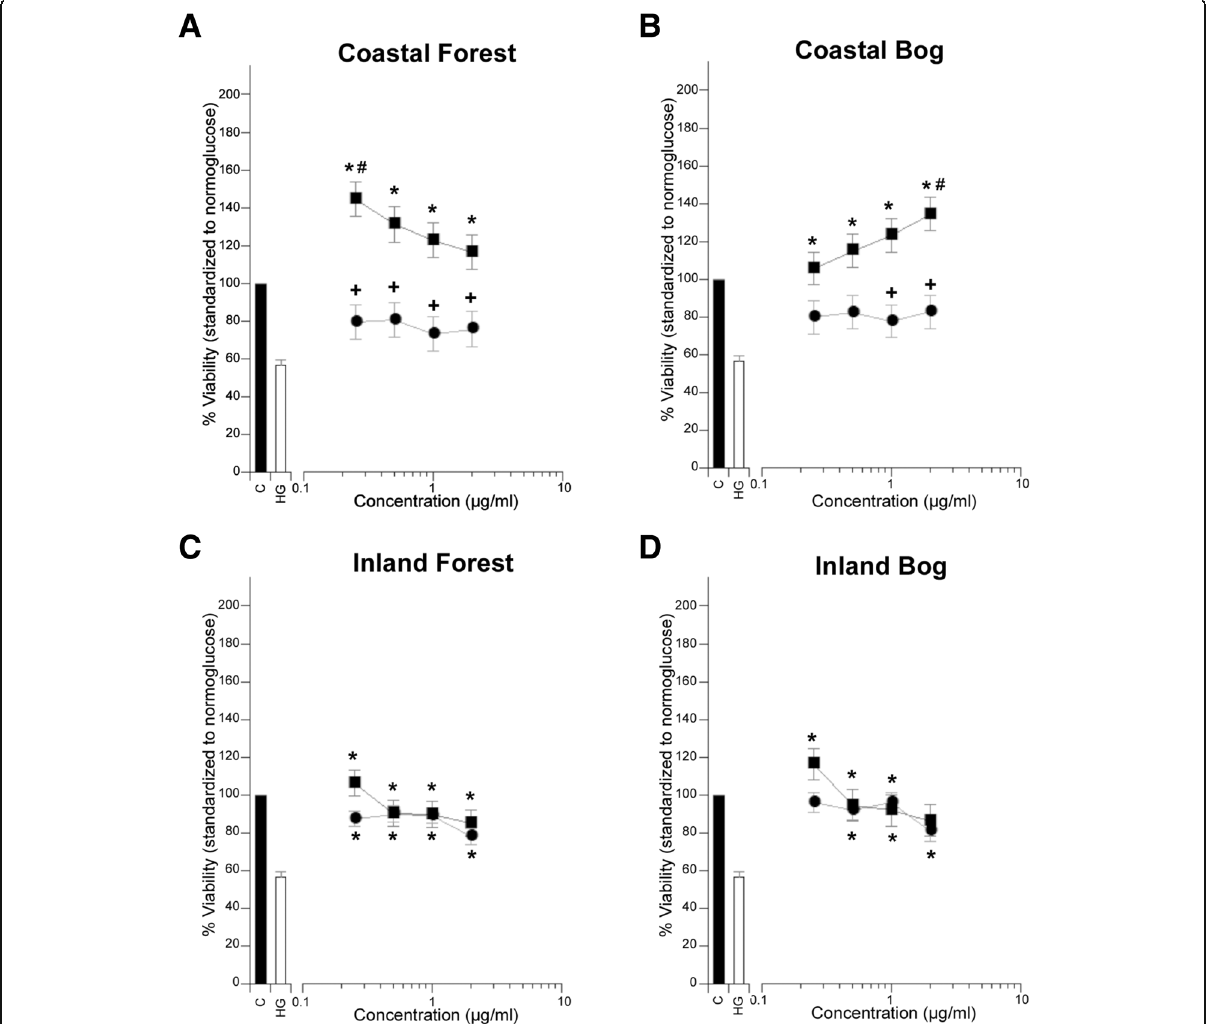
Fig. 3 Comparison of cytoprotective and mitogenic activities of P. mariana extracts on PC12-AC by growth environment. MANOVA analysis was used to determine the mean viability with respect to habitat (forest/ bog), growth environment (coastal/inland), organ type (Needle = ● , Bark = ■ ) and concentration (0.25, 0.50, 1.00, 2.00 μ g/mL) interactions. Significant protection ( * ) or mitogenic activity (#) was identified by Dunnett post hoc tests ( p ≤ 0.05) by comparison to the ( C ) normoglucose or ( HG ) high glucose controls respectively. The same p value was used to denote a significant difference between needle and bark ( + ) at specified concentrations. a Comparison of bark and needle extract protection in coastal forest environments (bark n = 12, needle n = 12). b Comparison of bark and needle extract protection in coastal bog environments (bark n = 12, needle n = 12). c Comparison of bark and needle extract protection in inland forest environments (bark n = 18, needle n = 51). d Comparison of bark and needle extract protection in inland bog environments (bark n =